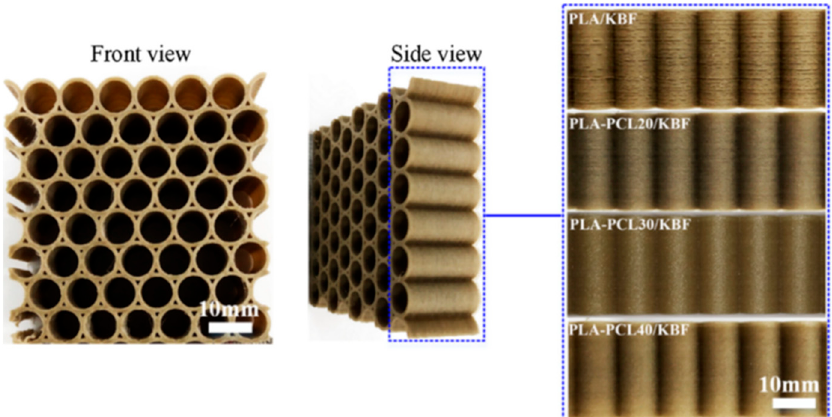
Figure 4. 3D printed circular honeycombs of PLA-PCL / KBF with varying ratios [38]. The PLA-PCL/KBF composite consists of polylactic acid (PLA) as the stiff matrix, polycaprolactone (PCL) as an elastomer phase and silane-treated basalt fibres (KBF) as the reinforcing filler.